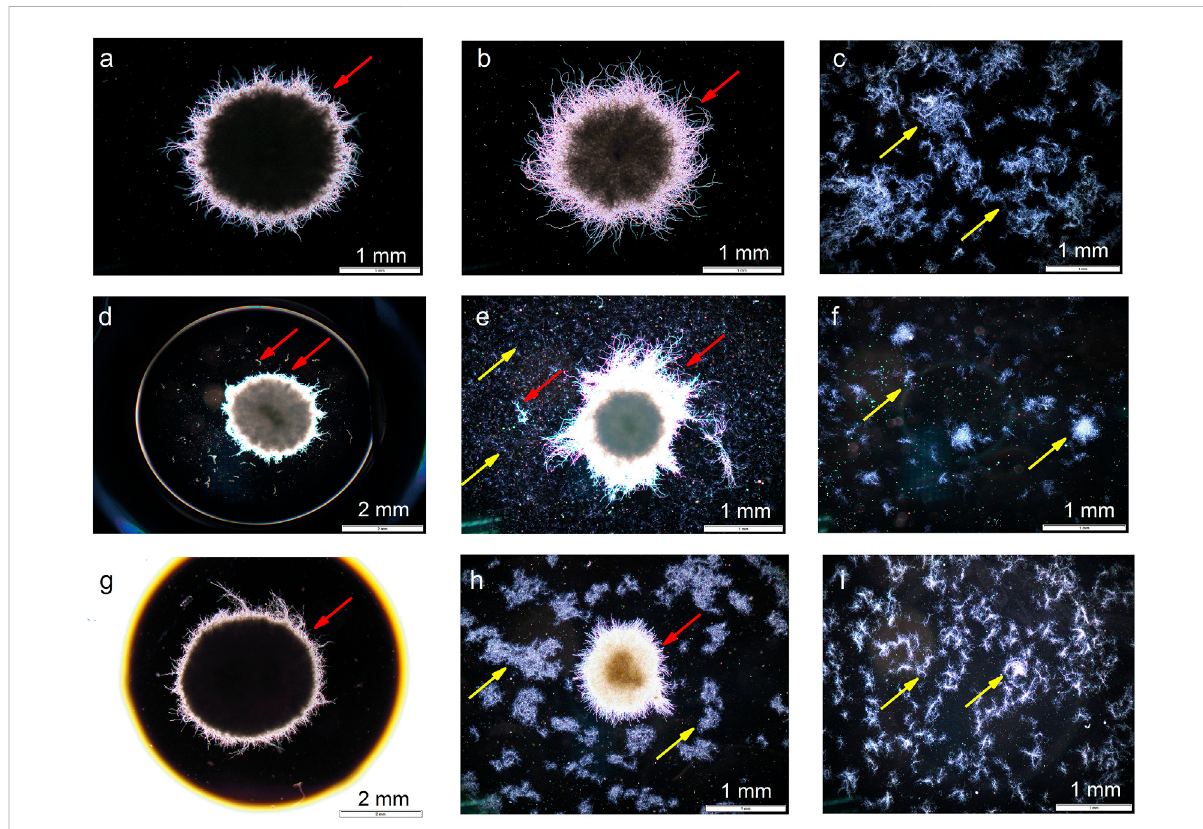
FIGURE 8 Microscopic images corresponding to (A) ATSN4 monoculture of A. terreus , (B) ATSN4 co-culture, (C) ATSN4 monoculture of S. noursei , (D) ATSN6 monoculture of A. terreus , (E) ATSN6 co-culture, (F) ATSN6 monoculture of S. noursei , (G) ATSN7 monoculture of A. terreus , (H) ATSN7 co- culture,and (I) ATSN7monocultureof S.noursei .Allimagesweretakenat48 hofthecultivationprocess.Redandyellowlinesdepict A.terreus and S. noursei ,